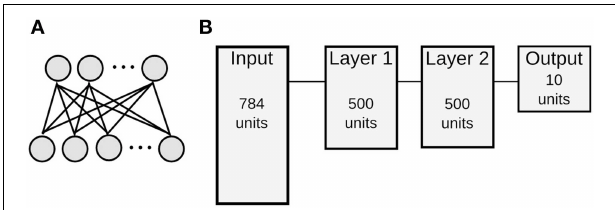
FIGURE 1 | Architecture of RBMs and DBNs. (A) Architecture of a single Restricted Boltzmann Machine with full connectivity between visible units (bottom) and hidden units (top), but no connections within the same layer. (B) Topology of a DBN for MNIST classification consisting of one input layer with 784 neurons, two hidden layers with 500 neurons each, and a 10 neuron output layer. This is abbreviated as 784-500-500-10 architecture.